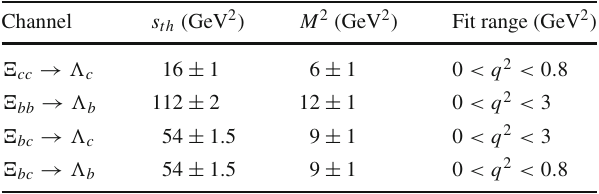
Table 2 Threshold s th of (cid:3) QQ (cid:3) , Borel parameters M 2 , and q 2 range for fitting form